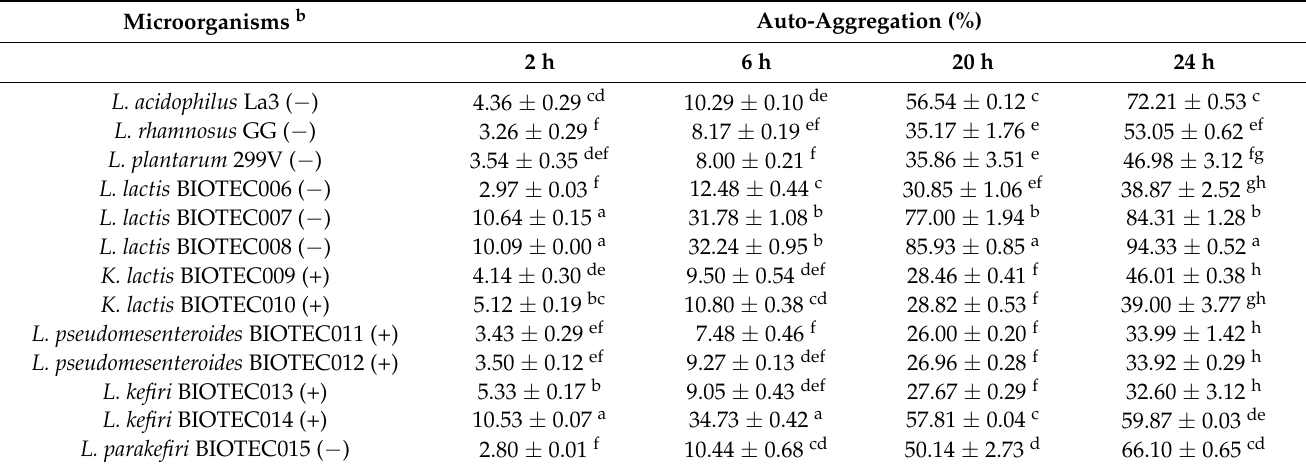
Table 2. Auto-aggregation abilities of the kefir isolates and commercial probiotics a . Microorganisms b